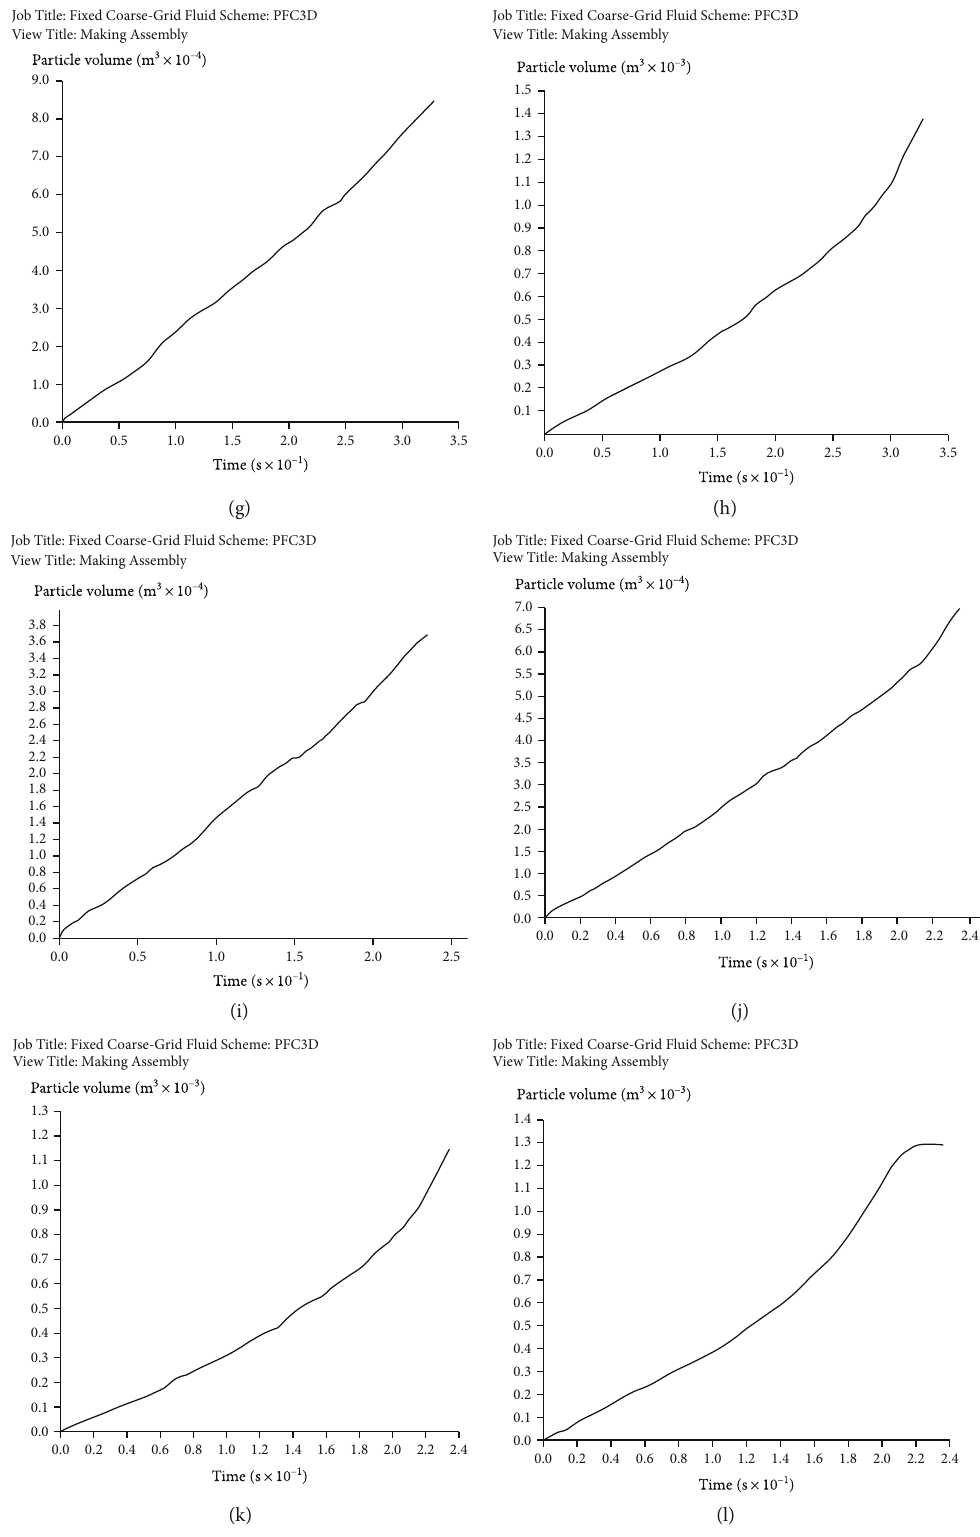
Figure 11: The relationship curve between seepage fl ow of particles and time under di ff erent water pressures for particle size of 100 × 100 × 300mm at (a) P = 0 : 5MPa , (b) P = 0 : 8 MPa , (c) P = 1 : 0 MPa , and (d) P = 1 : 2 MPa ; and particle size of 100 × 100 × 250 mm at (e) P = 0 : 5 MPa , (f) P = 0 : 8 MPa , (g) P = 1 : 0MPa , and (h) P = 1 : 2 MPa ; and particle size of 100 × 100 × 200 mm at (i) P = 0 : 5 MPa , (j) P = 0 : 8 MPa , (k) P = 1 : 0MPa , and (l) P = 1 : 2MPa